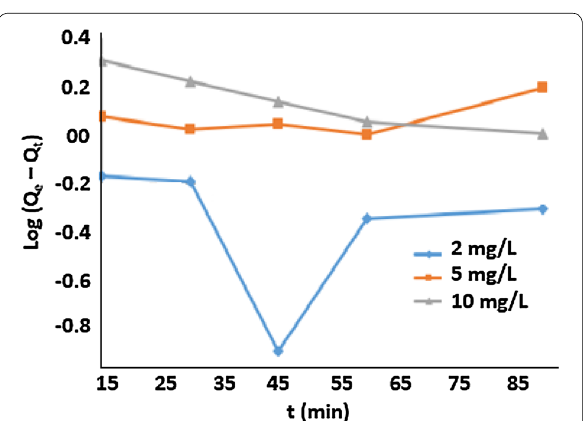
Fig. 13 Plot of pseudo first order kinetic modelat 2, 5 and 10